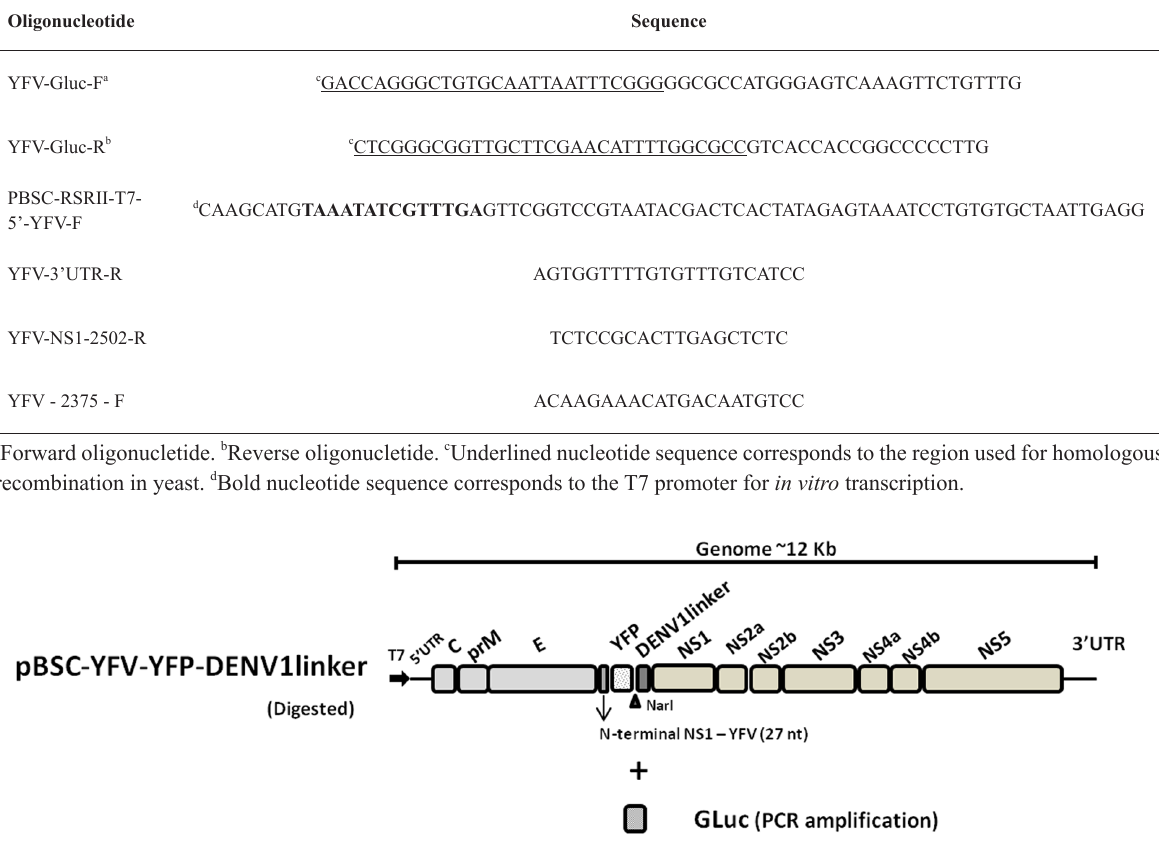
Oligonucleotides used for pBSC-YFV-GLuc construction and in vitro transcription. Oligonucleotide Sequence